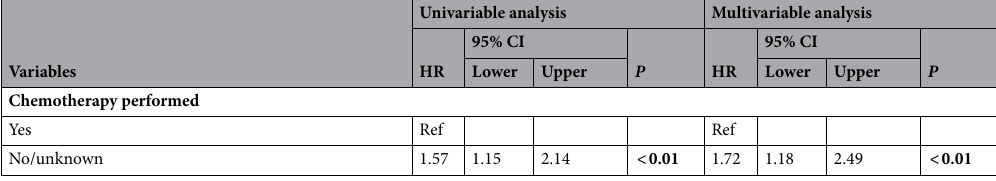
Table 3. Univariable and multivariable analysis for the suicide of esophageal cancer patients. SMR, standardized mortality ratio; SEER, the surveillance, epidemiology, and end results; HR, Hazard Ratio; 95% CI, 95% confidence interval; NOS, Not Otherwise Specified. a Included divorced, widowed and separated. b Included never married. # The Bonferroni-corrected P value was used for multiple comparisons. $ The chi- square test for linear trend was used for ordinal multi-categorical variables. The P and HR values in the bold were statistically significant or considered to be analyzed in multivariate regression